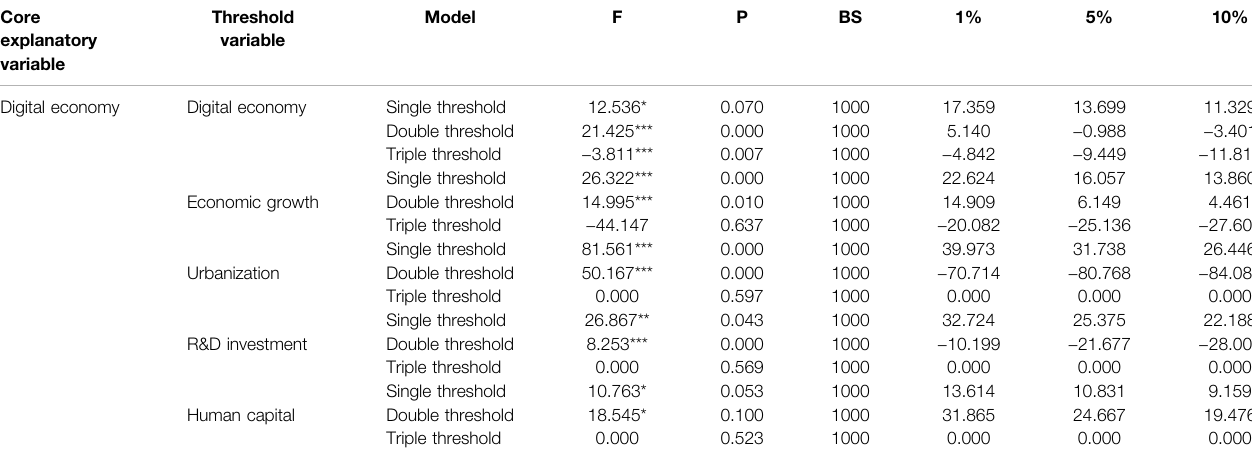
TABLE 9 | Threshold effect self-sampling test.